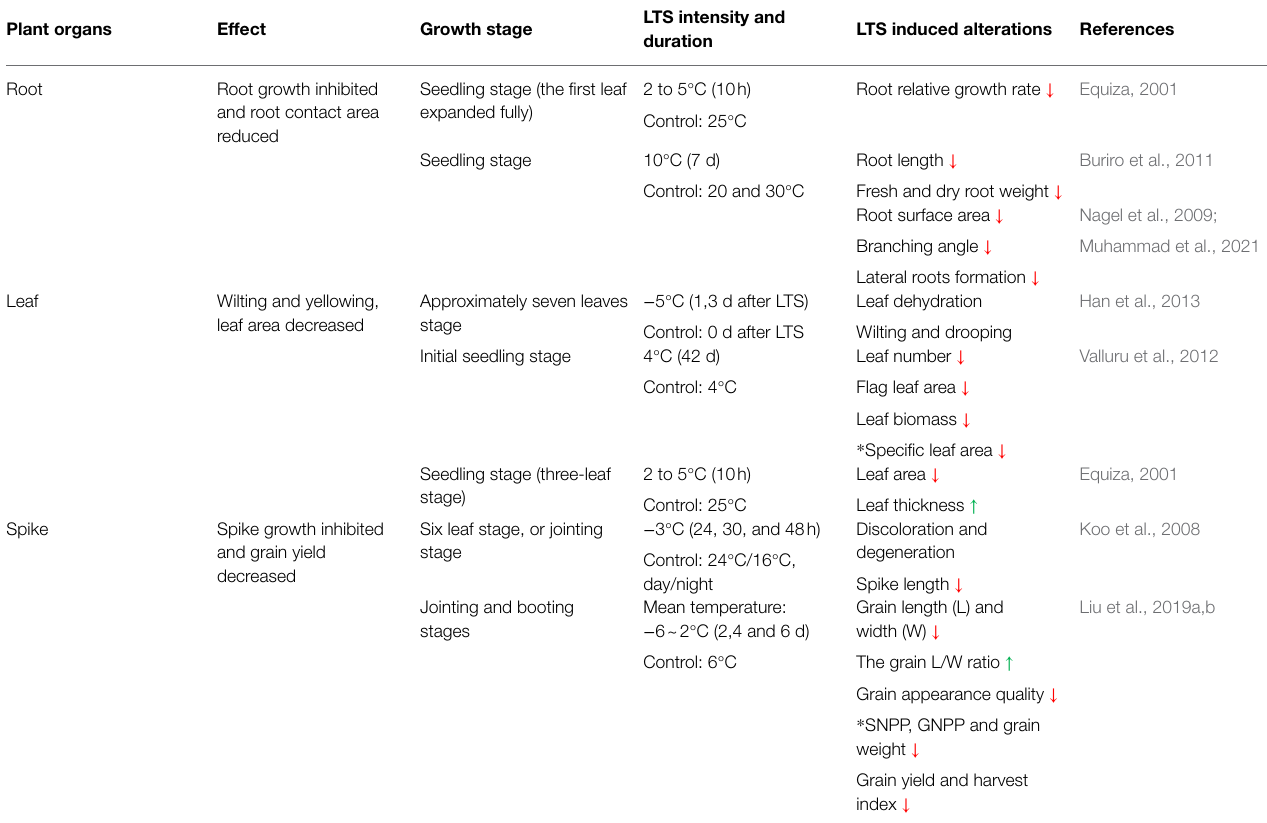
TABLE 2 | Morphological traits of source-sink organs of wheat, influenced by LTS. Plant